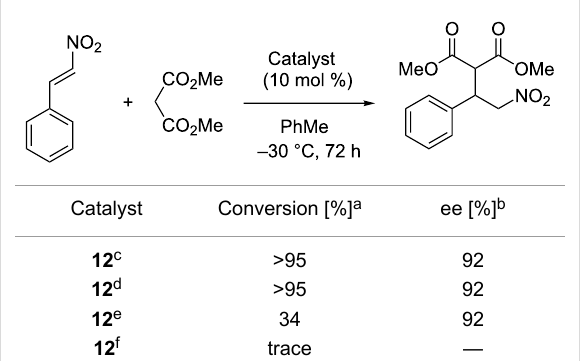
Table 4: Polymer-supported thiourea Cinchona organocatalyst in the asymmetric Michael addition.